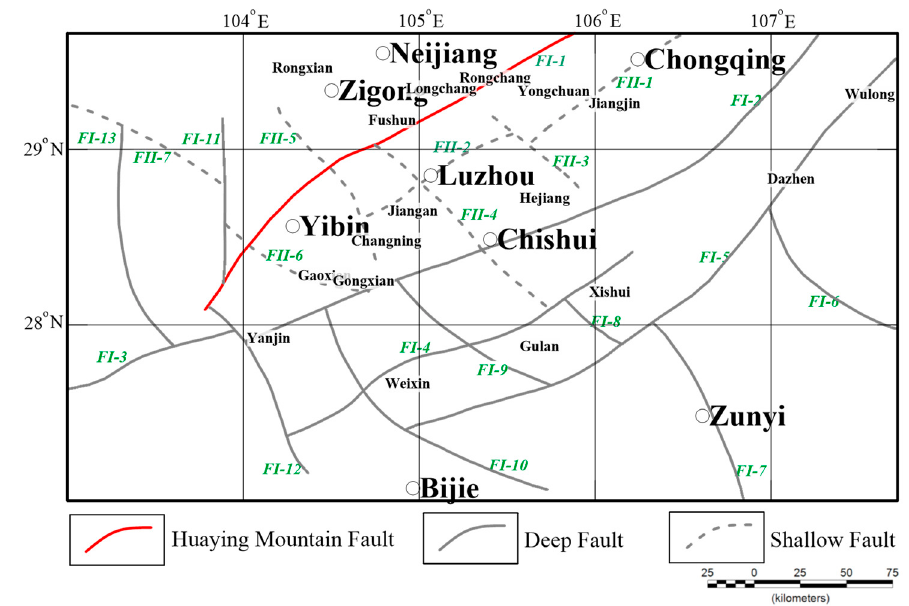
Figure 9. The inferred results of faults’ planar characteristics.